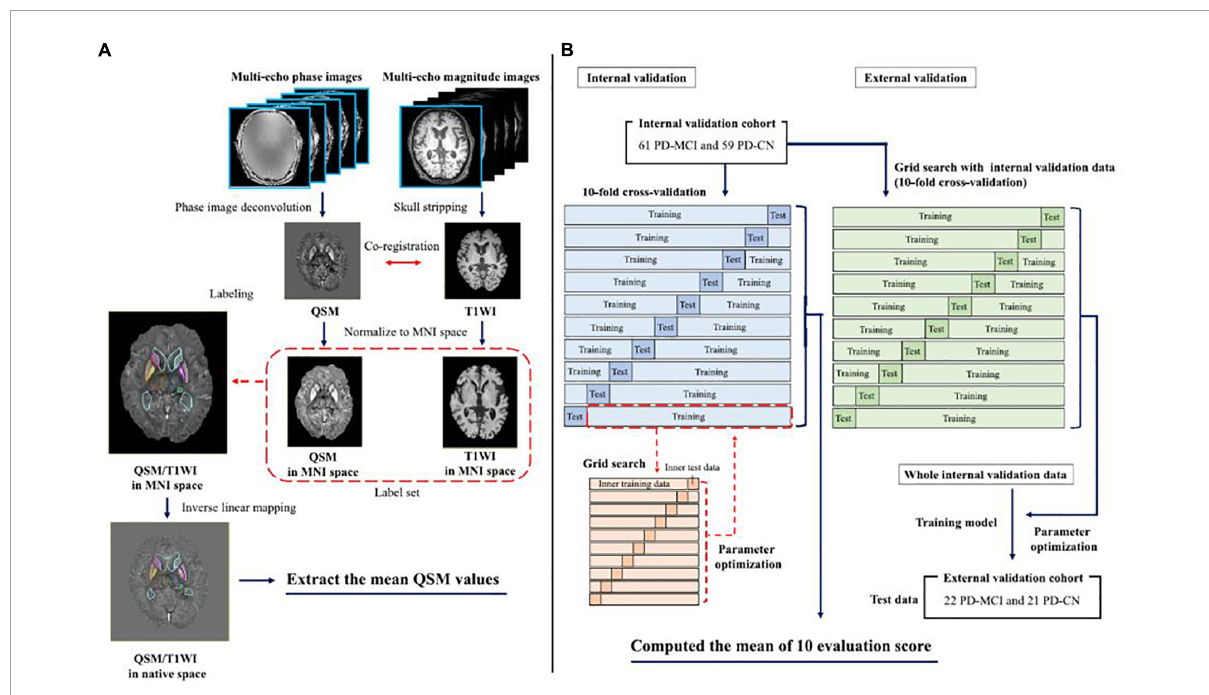
FIGURE3 The left-hand panel shows the pipeline for the multi-atlas approaches for each individual QSM/T1WI image through the MRICloud platform (https://mricloud.org/) (A) . The right-hand panel shows the pipeline for developing the machine learning-based models (B) . MNI, Montreal Neurologic Institute; PD-MCI, Parkinson’s disease with mild cognitive impairment; PD-CN, Parkinson’s disease with normal cognition; QSM, quantitative susceptibility mapping; T1WI, T1-weighted image (adapted with permission from Shibata et al.,